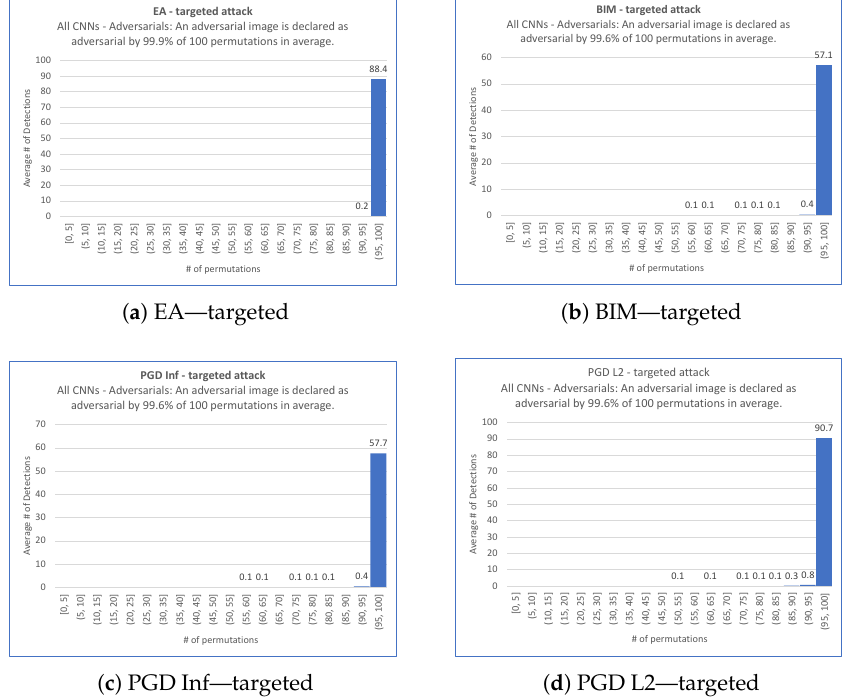
Figure 3. Average outcome over the 10 CNNs of ShuffleDetect performed with 100 permutations on the adversarial images created for the target scenario by EA, BIM, PGD Inf, and PGD